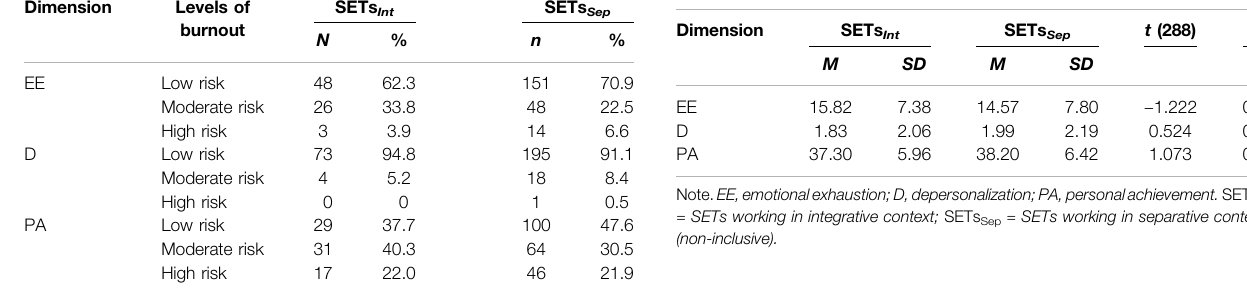
TABLE 8 | Distribution of SETs in the three dimensions of the MBI. Dimension Levels of